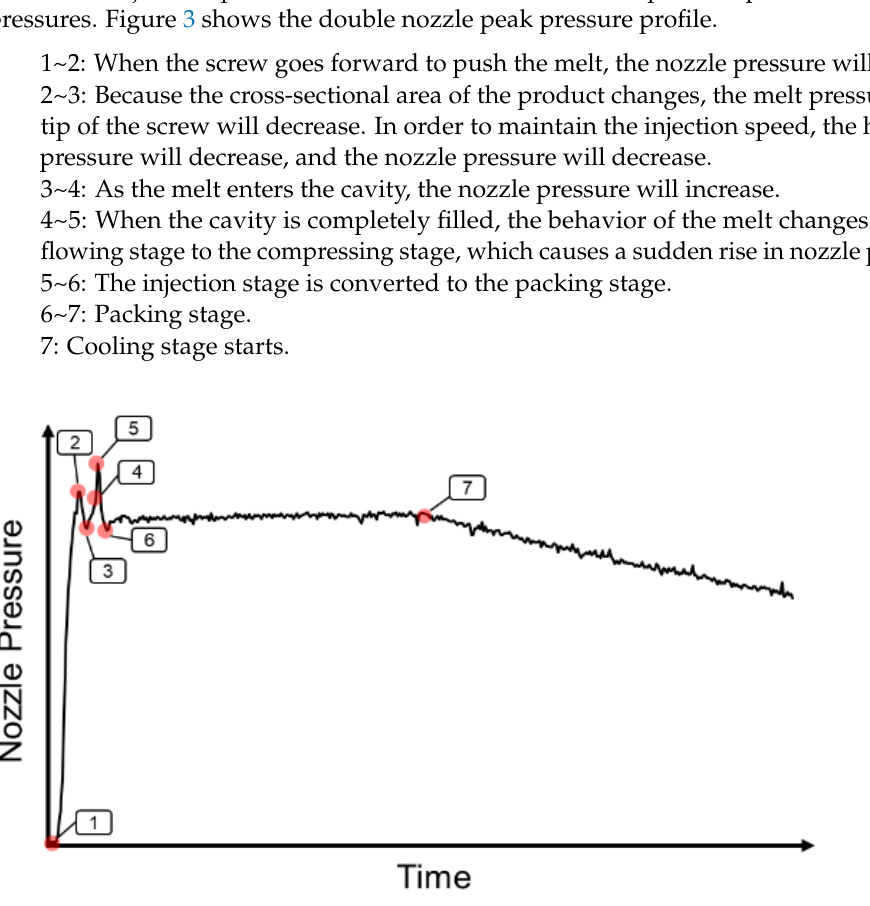
Figure 3. Double nozzle peak pressure profile.